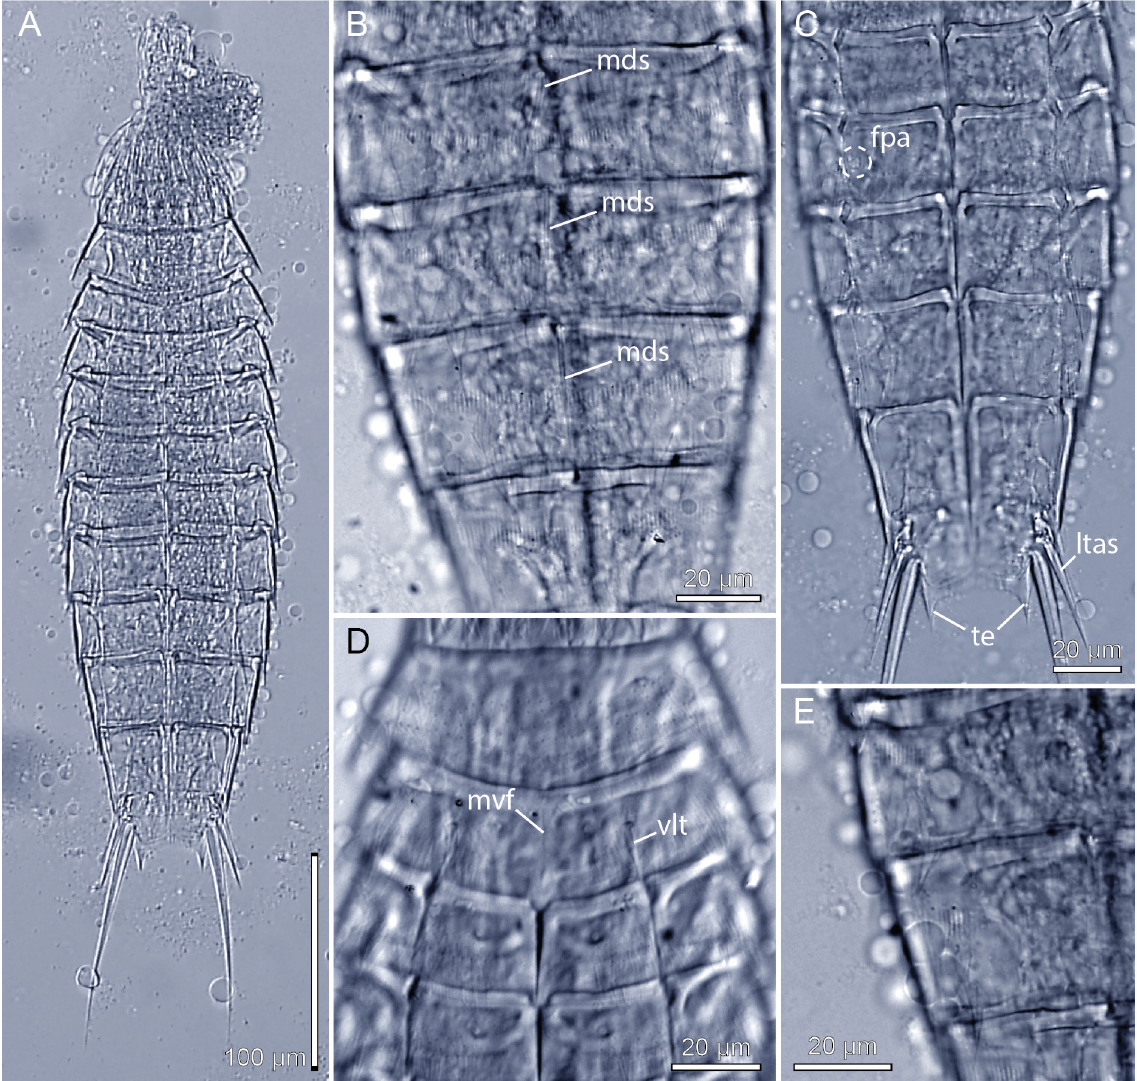
Fig. 18. Light micrographs showing overviews and details of Echinoderes lanceolatus Chang & Song, 2002, holotype, ♀ (EWNHM60268), species now junior synonym of Echinoderes aureus Adrianov et al ., 2002. A . Ventral overview. B . Segments 7 to 10, dorsal view. C . Segments 6 to 11, ventral view. D . Segments 1 to 4, ventral view. E . Details showing laterodorsal and midlateral parts of segments 8 and 9, documenting the absence of glandular cell outlet type